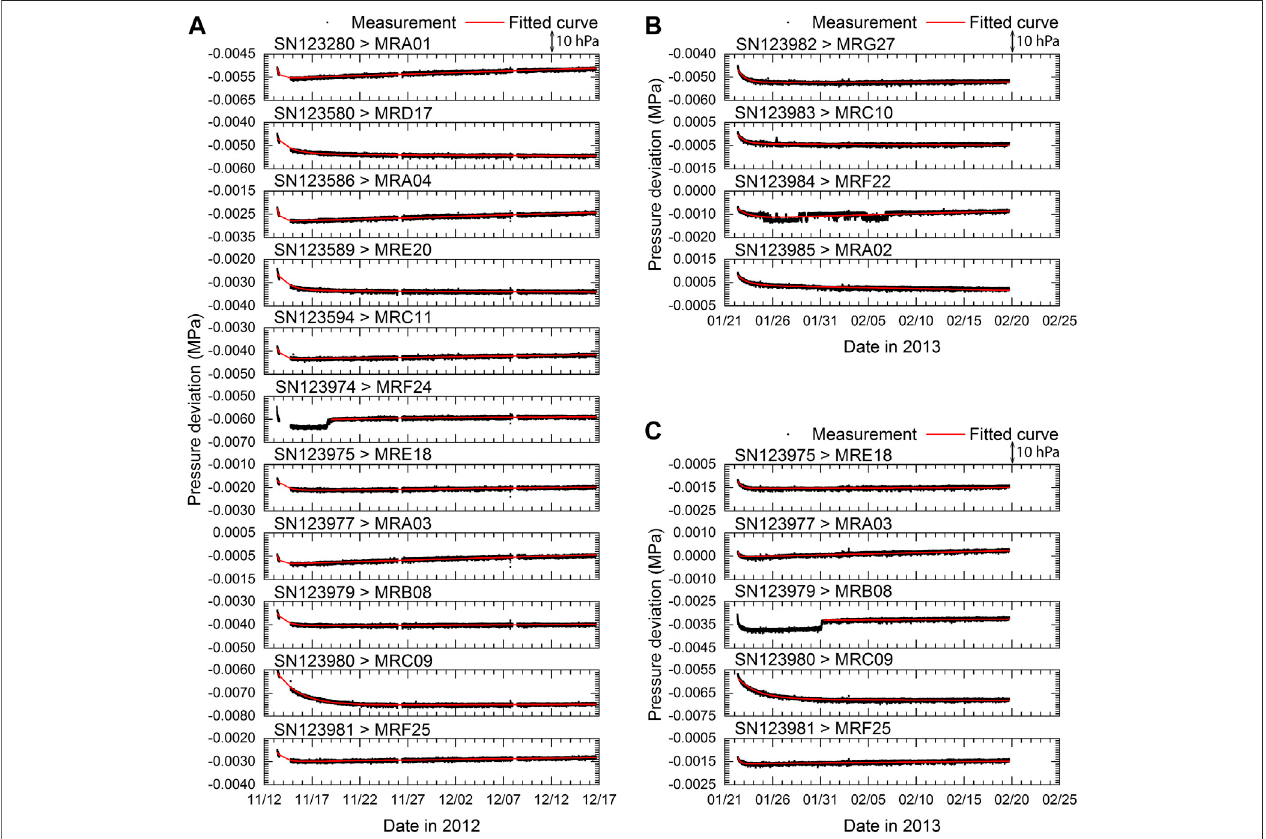
FIGURE 8 | Deviation from the pressure standard (i.e., the reference pressure) during the experiment. The serial numbers of a pressure sensor and the observatory namestobedeployedintotheDONETobservatoriesareshownineachpanel.Theverticalaxisrepresentstheabsolutepressuredeviationinmega-Pascal.The fi ttedcurves derived from Eq. 1 are also plotted as red lines. Experiments were conducted in (A) November 2012 and (B, C) January 2013. (C) Five pressure sensors were repeatedly pressurized.